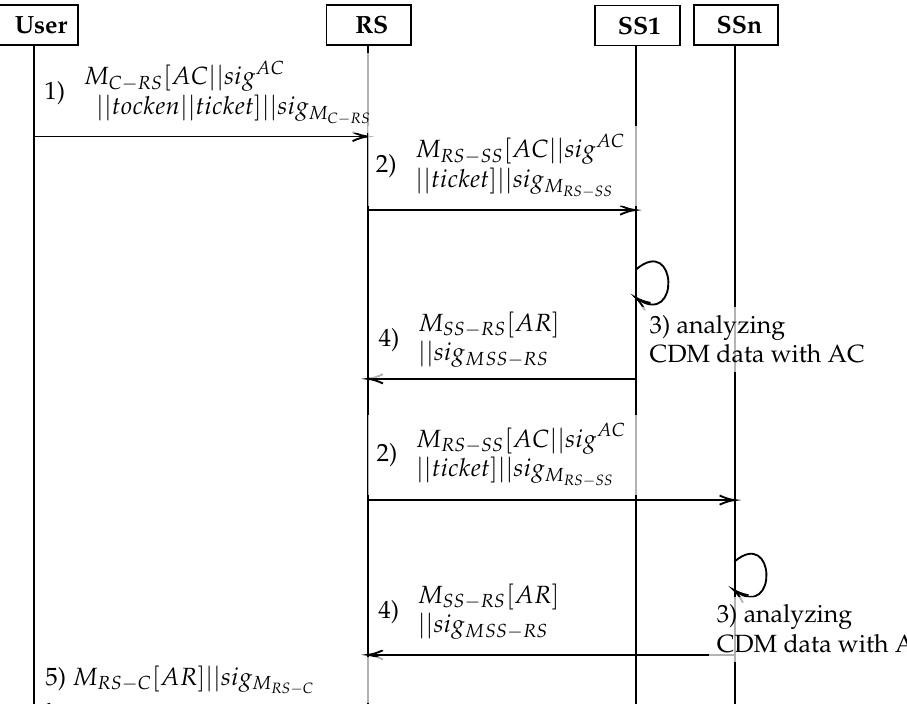
Figure 5. Sequence diagram for distributing AC in full-automation